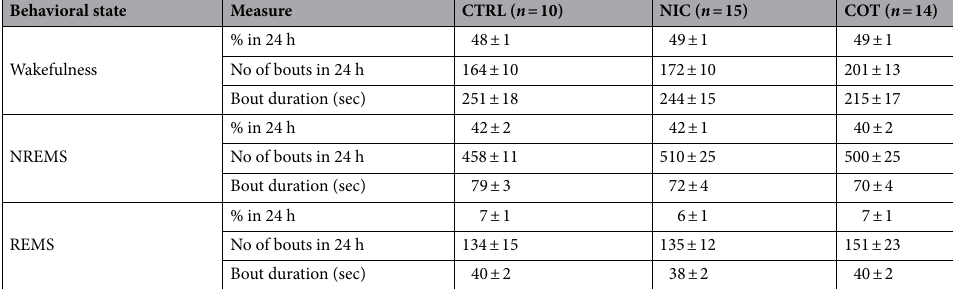
Table 1. Wake-sleep cycle architecture in mice perinatally exposed to nicotine, cotinine or vehicle. The table shows the total duration (percentage of recording time), the number of bouts and the mean bout duration of wakefulness, non-rapid-eye-movement sleep (NREMS) and rapid-eye-movement sleep (REMS) of adult male mice perinatally exposed to nicotine (NIC), cotinine (COT) or just the vehicle (CTRL) recorded during baseline